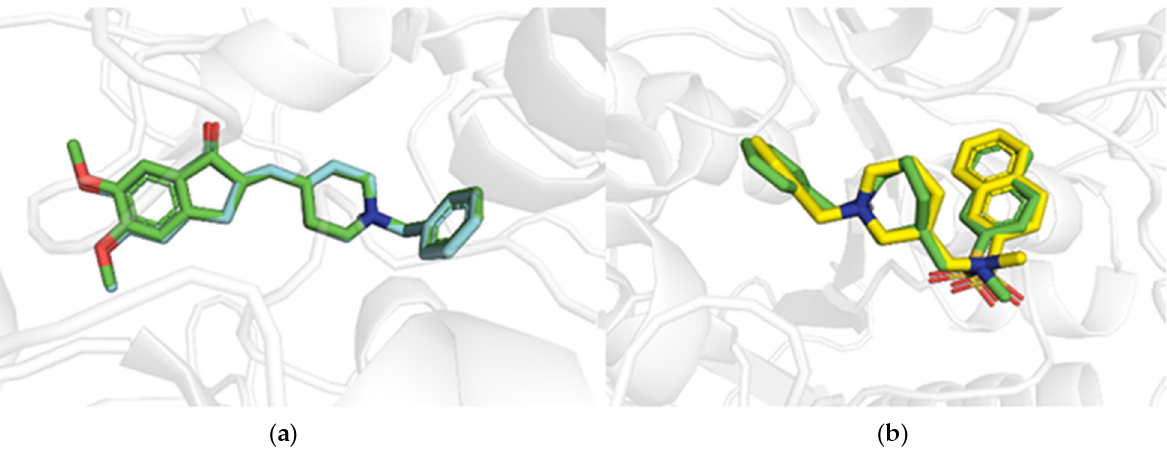
Figure 5. Overlaps of the X-ray solved (green sticks) and docking poses for donepezil for hAChE (PDB entry: 4EY7) ( a ) and KJT for hBChE (PDB entry: 6RUA) ( b ), rendering in cyan and yellow sticks, respectively.